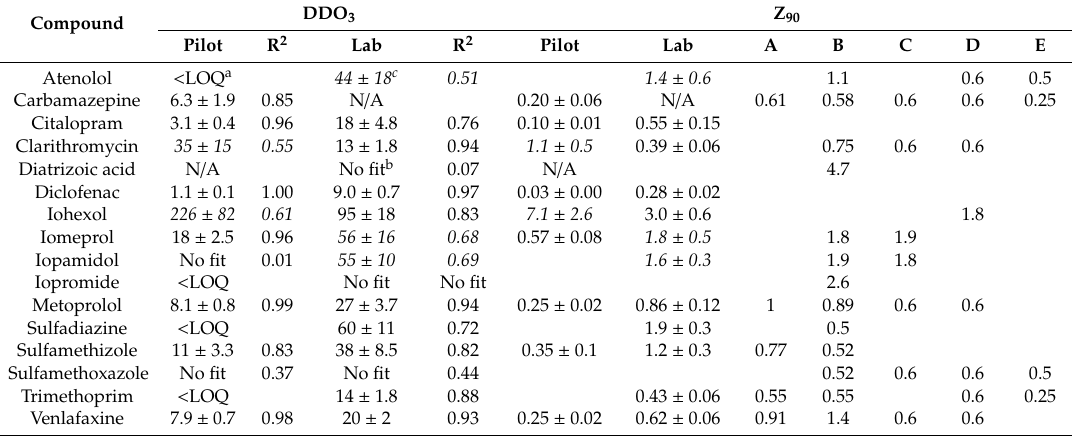
Table 3. Delivered ozone dosage for 90% removal of pharmaceuticals in the pilot and the laboratory, and the normalisation of delivered ozone dosage to the relevant DOC condition (Z 90 , DDO 3 / DOC, (mg O 3 / mg DOC)). The DOC for this study was 32 mg / L. Indicated intervals represent the standard deviation. DDO 3 Compound